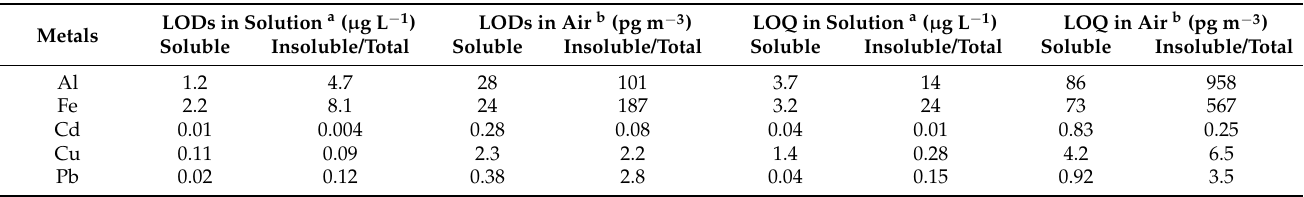
Table 1. Limits of detection (LOD) and of quantification (LOQ) for the studied metals in the two fractions (soluble and insoluble) and in the direct measurement of total